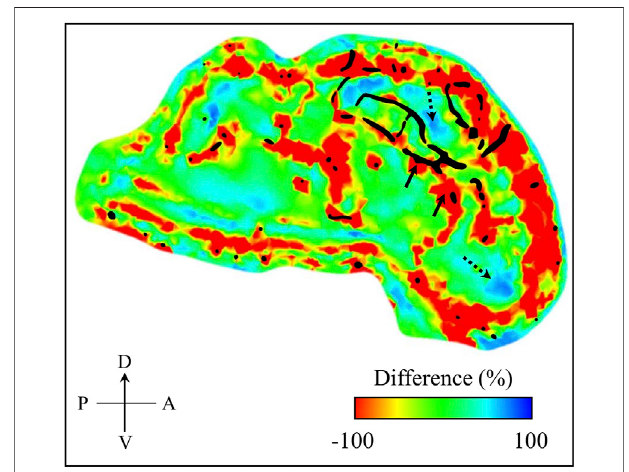
FIGURE 9 | Percentage difference in maximum principal strain between the minipig-head model with and without vasculature. We computed this difference map over the mid-sagittal plane at time t (cid:1) 4.36 ms into the simulation. For context, we superimposed the vasculature (represented by the black shaded region) over the mid-sagittal plane of the brain geometry used in our model. Through the difference map, we observed both decrease (indicated by solid-line arrows) and increase (indicated by dotted-line arrows) of maximum principal strain in the brain. A: anterior; D: dorsal; P: posterior; V: